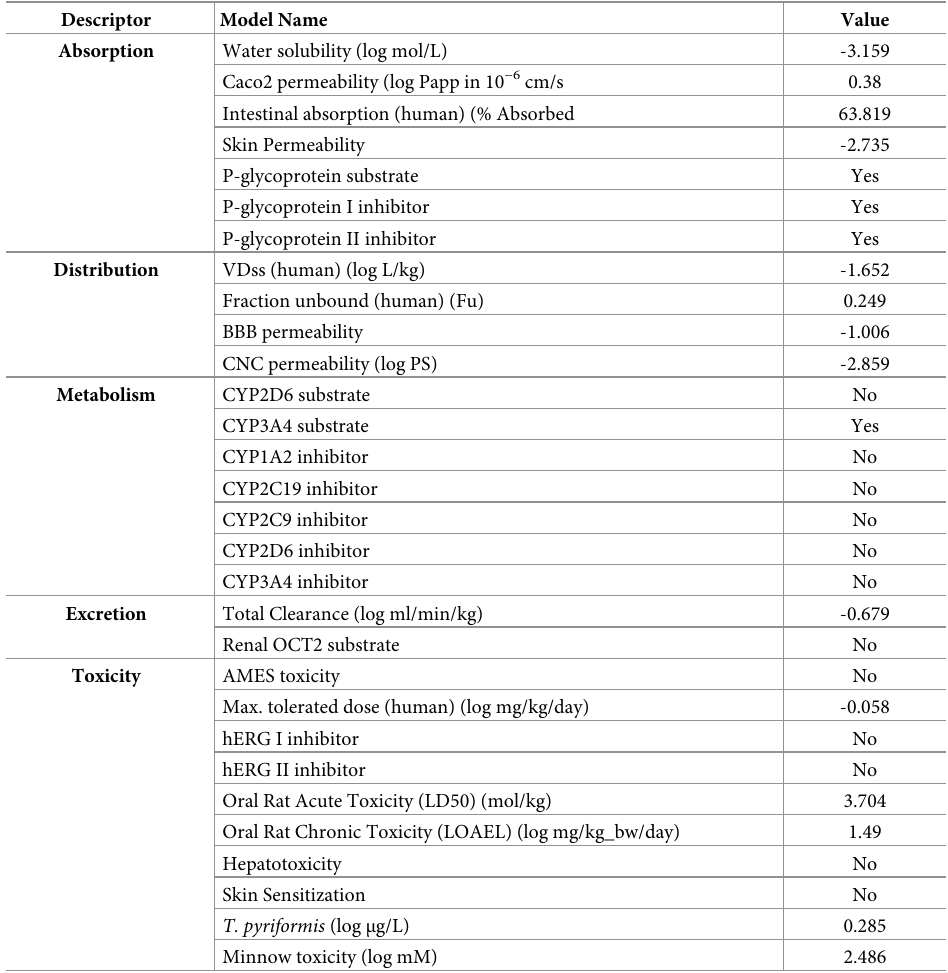
Table 3. Predicted ADMET properties of